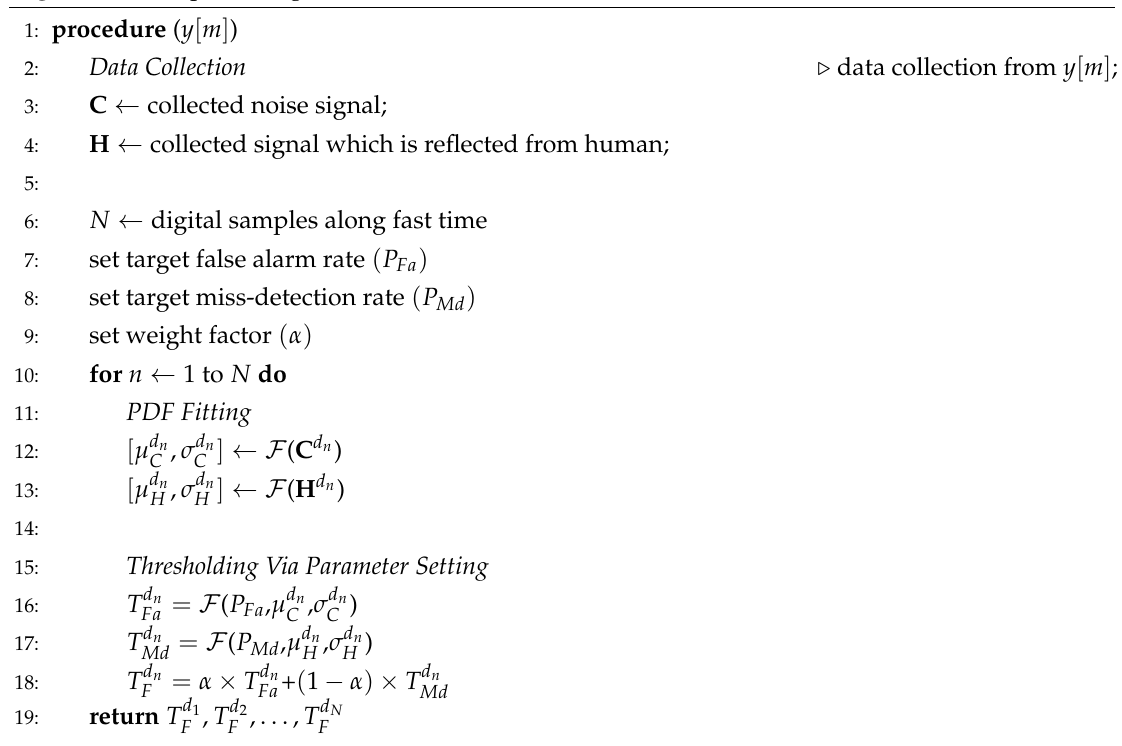
Algorithm 1 Proposed